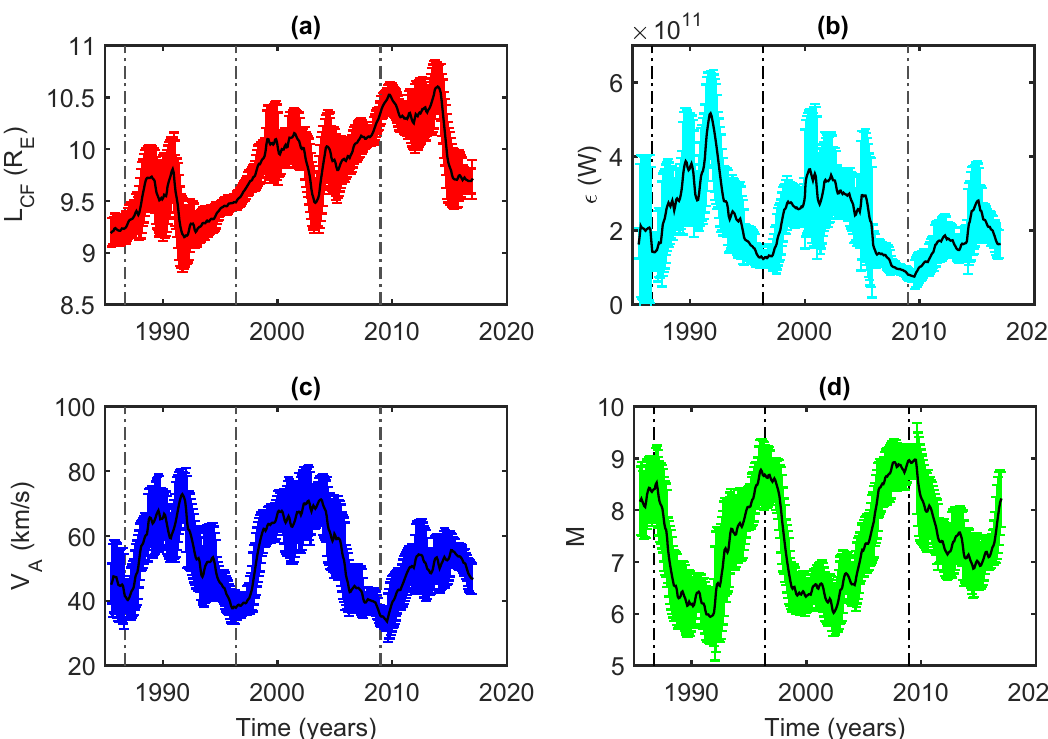
Fig. 6. Variation of monthly smooth (a) Chapman-Ferraro magnetopause distance, L CF , (b) solar wind-magnetosphere energy coupling function, e , (c) Alfven speed, V A and (d) solar wind plasma magnetosonic Mach number, M for SCs 22, 23, and 24. The vertical dashed-dotted lines indicate the start of SC 22, 23, and 24. The 13-month smooth variations of these parameters are shown by black solid